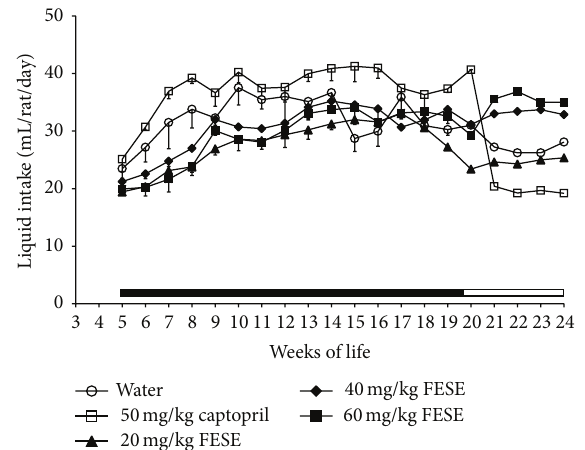
Figure 3: Liquid intake of spontaneously hypertensive rats. The ani- mals drank different fluids from weaning until the 20th week of life (treatment period = T, indicated by a solid bar) and received there- fore different daily treatments: tap water, 20 mg/kg/day Fraxinus excelsior L. seed extract (FESE), 40 mg/kg/day FESE, 60 mg/kg/day FESE, or 50 mg/kg/day captopril. All rats drank tap water from the 20th week of life until the 24th week of life (follow-up period = F, indicated by an open bar). Data are mean values ± SEM for 10 animals in T and for 5 animals in F. Similar letters represent no statistical differences ( 𝑃 > 0.05 ). 𝑃 estimated by two-way